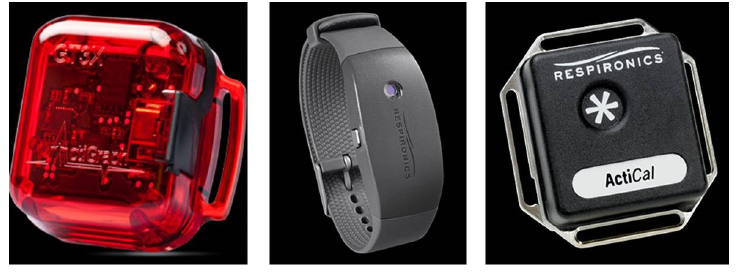
Figure 3. Example of